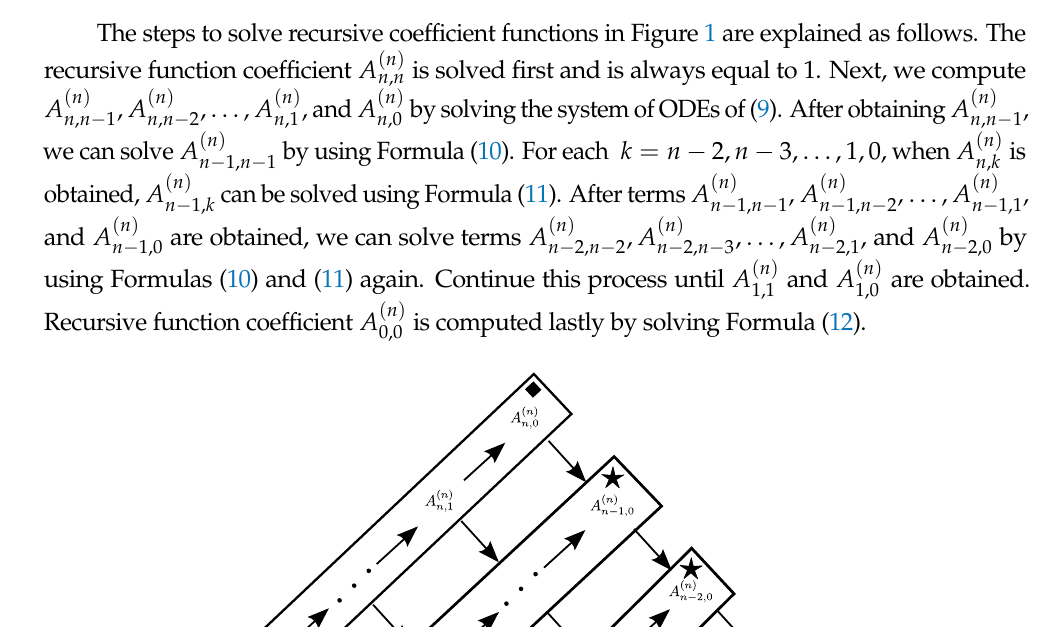
( n ) ( n ) . n , n to A 0,0